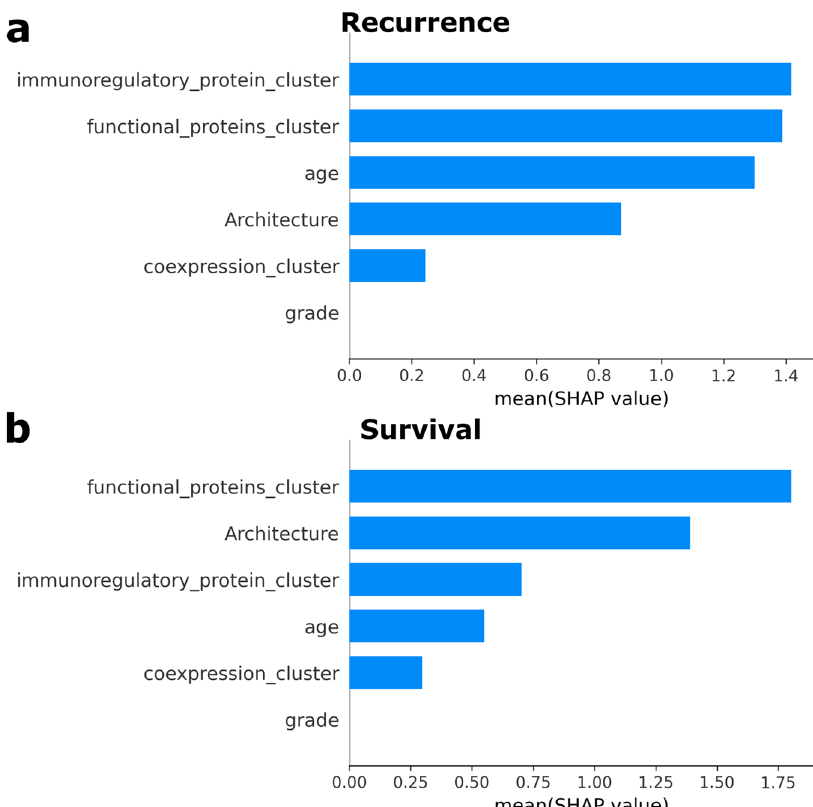
Fig. 5 Random forest variable importance. a Bar plot showing the mean SHAP value for each variable in a random forest predicting recurrence, with n = 38 TNBC images. SHAP (Shapley additive explanations) values are a measure of variable importance that quanti fi es how the expected model prediction would change when conditioning on a certain variable. They are more aligned with human intuition than other feature attribution methods. b Bar plot showing the mean SHAP value for each variable in a random forest predicting survival, with n = 38 TNBC